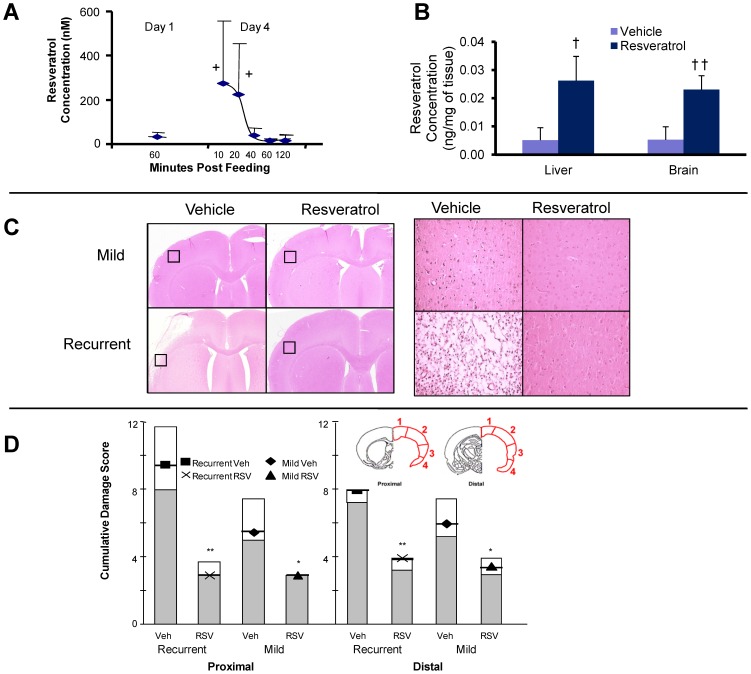
Mean (±SD) amounts of resveratrol (RSV) detected in the plasma (A), and liver and brain tissue (B), of naive animals treated with daily oral doses of RSV (25 mg/kg).Hematoxylin and eosin stained sections (C) from scanned sections (left) and magnified insets (20x; right) depict scattered cell death following a single mild stroke and extensive cell death following a recurrent stroke. Less cell death is observed with RSV treatment. Quantitative assessment of damage as a cumulative injury score (D) demonstrated that there was reduced cell death in the RSV treated groups compared with the respective vehicle (Veh) treated group in either proximal or distal cerebral cortex. Data presented as median (+/− first and third quartile). Different from respective vehicle (Veh): +P<0.05 (ANOVA and Dunn's Test), †P<0.05 or ††P<0.006 (Students t-test), *P<0.03 or **P<0.002 (ANOVA on ranks and Mann-Whitney Rank Sum Test).